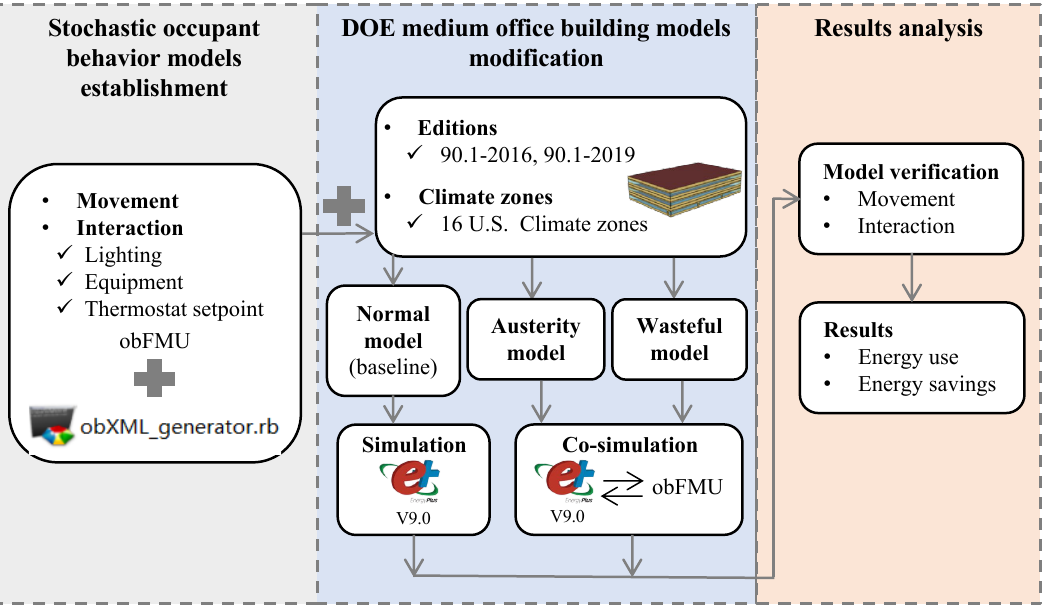
Figure 1. An overview of the framework.